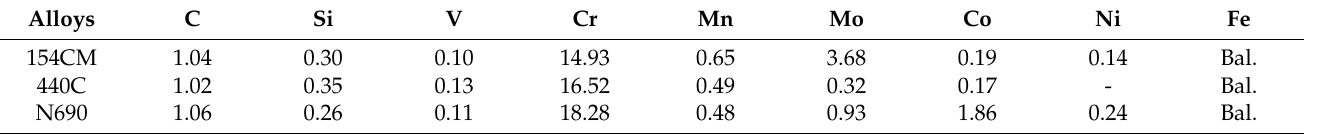
Table 1. Composition of three martensitic stainless steels